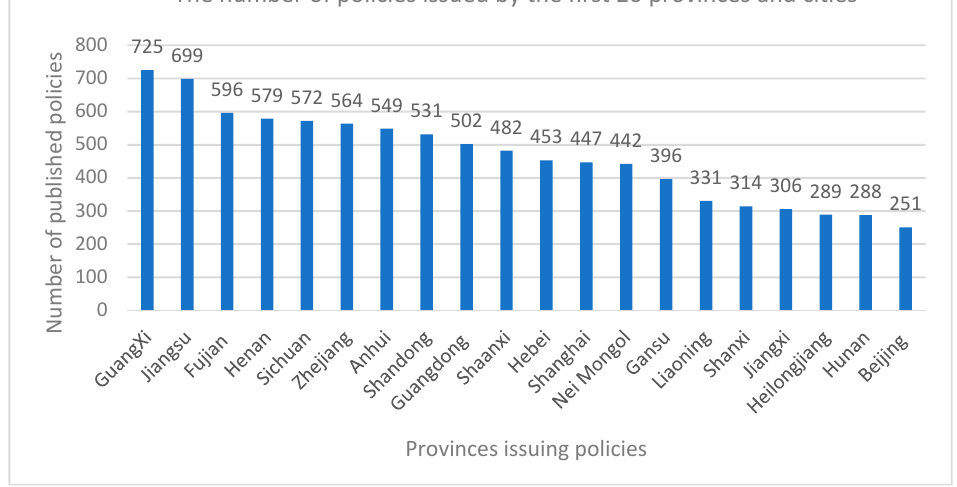
Figure 5. Regional distribution of food safety policies in China (2008–2022).